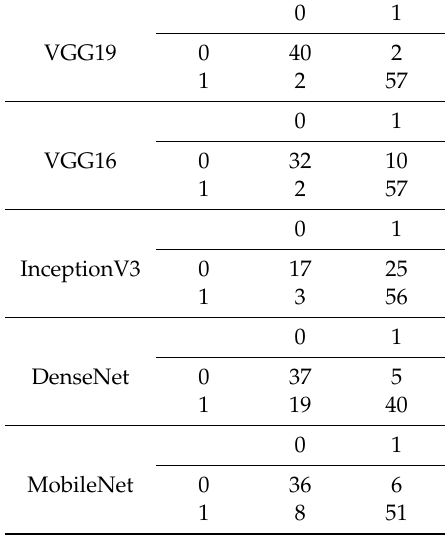
Table 4. Confusion matrix of the prediction of the NOROP and ROP derived from the classification